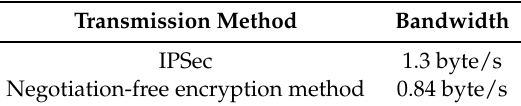
Table 5. Average bandwidth.